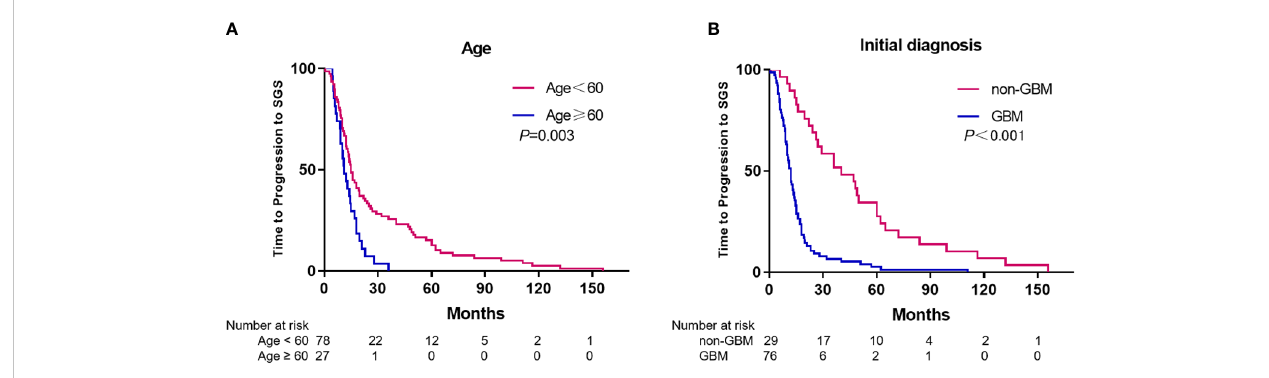
FIGURE 2 Kaplan-Meier estimates of time to progression to SGS strati fi ed by age (A) and initial diagnosis (B) .